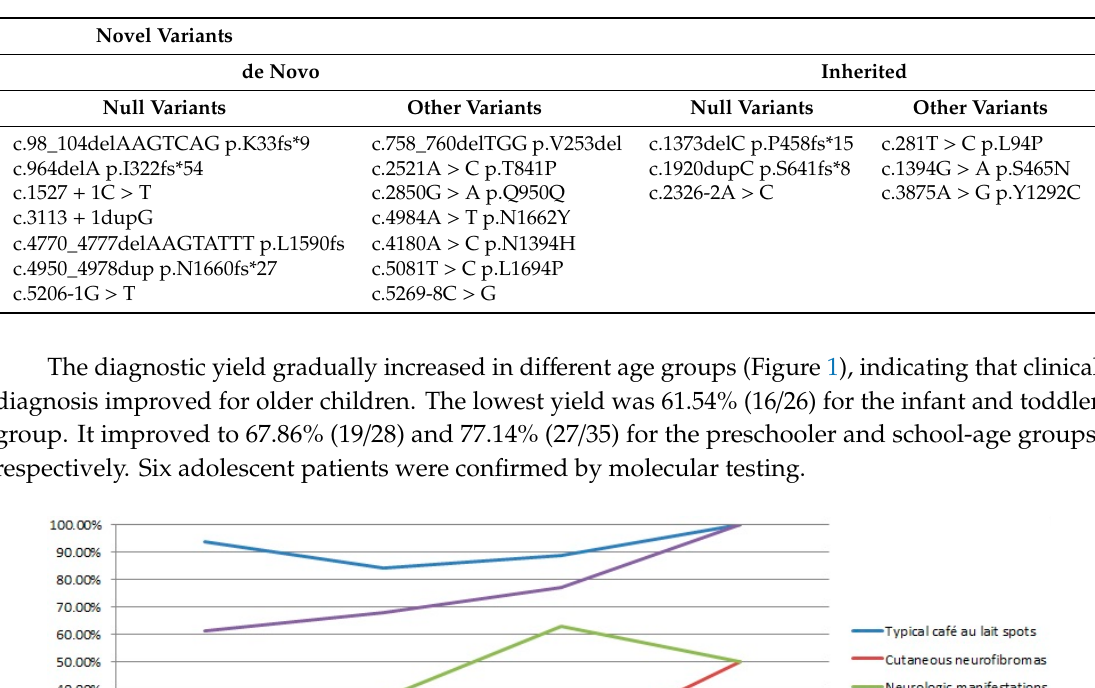
Table 1. Novel variants detected in Chinese neurofibromatosis 1 (NF1) patients.